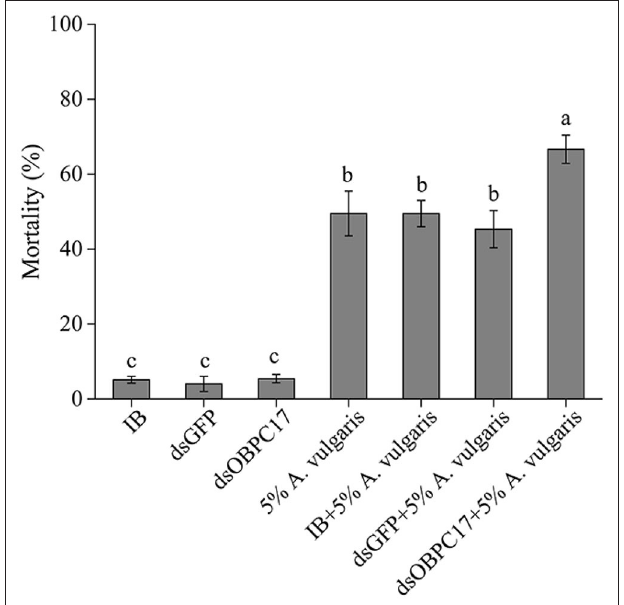
FIGURE 6 | Bioassay of T. castaneum larvae exposed to A. vulgaris EO after injection with dsOBPC17. The mortality rates of T. castaneum larvae were recorded following dsOBPC17 injection with or without exposure to A. vulgaris EO (36h). The larvae injected with the equal volume of water (IB) or dsGFP served as the controls. The bars indicate the standard errors of three to seven biological replicates. The statistical significance of the mortality rate was analyzed with Fisher’s LSD test. Different letters above the error bars represent significant differences among treatments at P < 0.05.